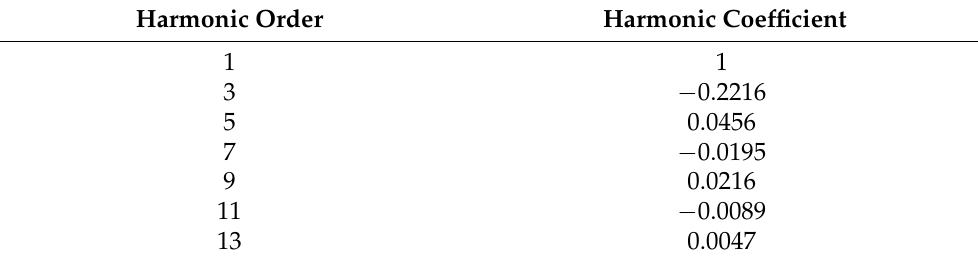
Figure 9. ( a ) The back EMF of the motor in 2500 rpm ( b ) FFT of the back EMF. Table 4. The harmonic contents of motor back